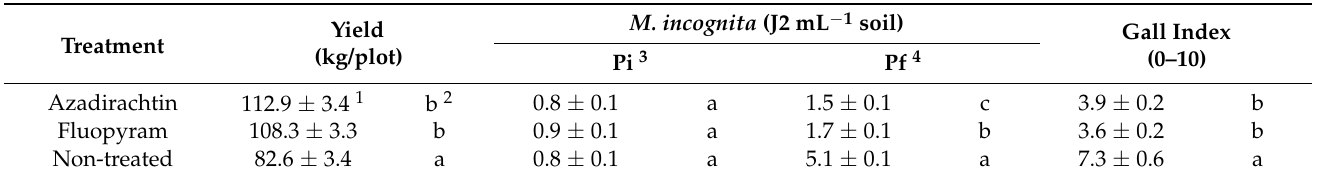
Table 1. Effect of treatments with azadirachtin and fluopyram on the control of Meloidogyne incognita on lettuce and on crop yield, 45 days after transplant.